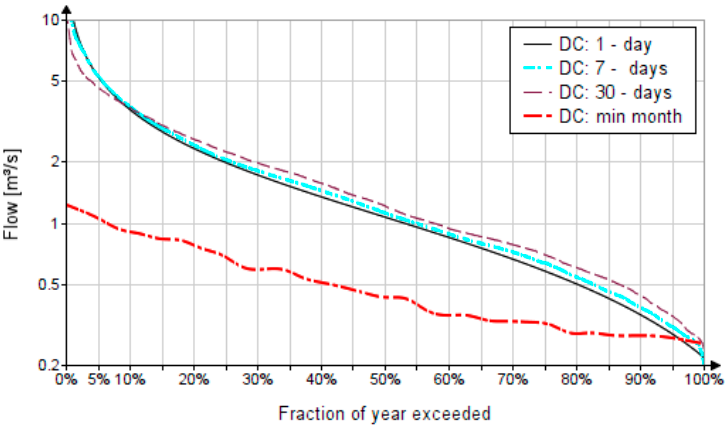
Figure 1. Duration curves for Prigor river.